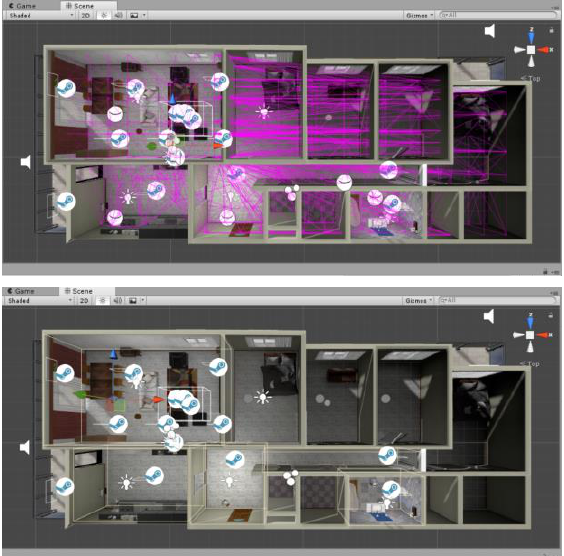
Figure 2. 2D floor plan (upper), and its 3D view with split screen in Sweet Home 3D. (bottom)